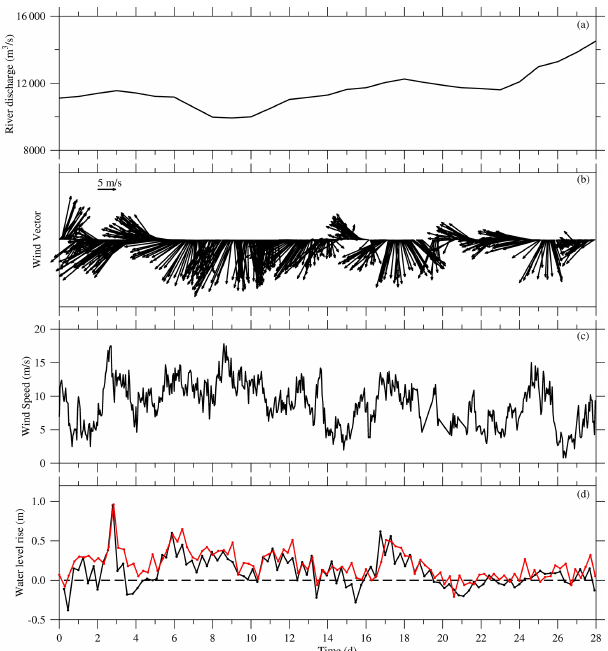
Figure 4. Temporal variations in the measured river discharge at Datong station (a) . Wind vector (b) and wind speed (c) at WS and water level rise obtained by subtracting the data in the tide table from the measured water level at Sheshan station (black line) and Luchaogang station (red line) in February 2014 (d)